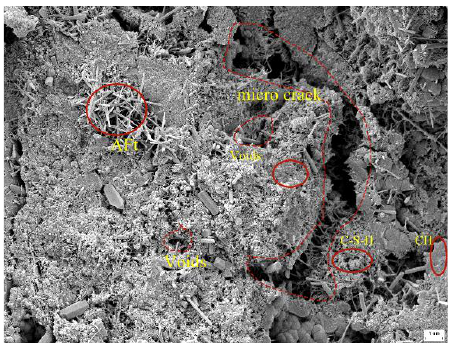
Figure 10. SEM photograph of 15% ferrochrome slag powder. Figure 9. SEM photograph of 0% ferrochrome slag powder . Figure 9. SEM photograph of 0% ferrochrome slag powder.